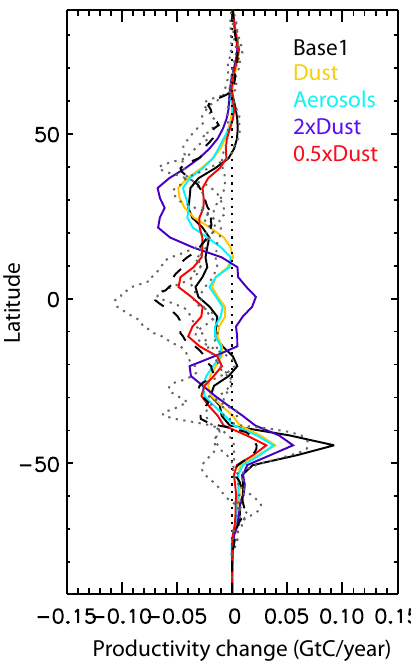
Fig. 17. Zonally averaged ocean productivity changes (2080–2099 compared to 1870–1889) from the simulations presents here (color and solid black lines), compared to the results from (Steinacher et al., 2010) (mean: dotted black, various models: dotted